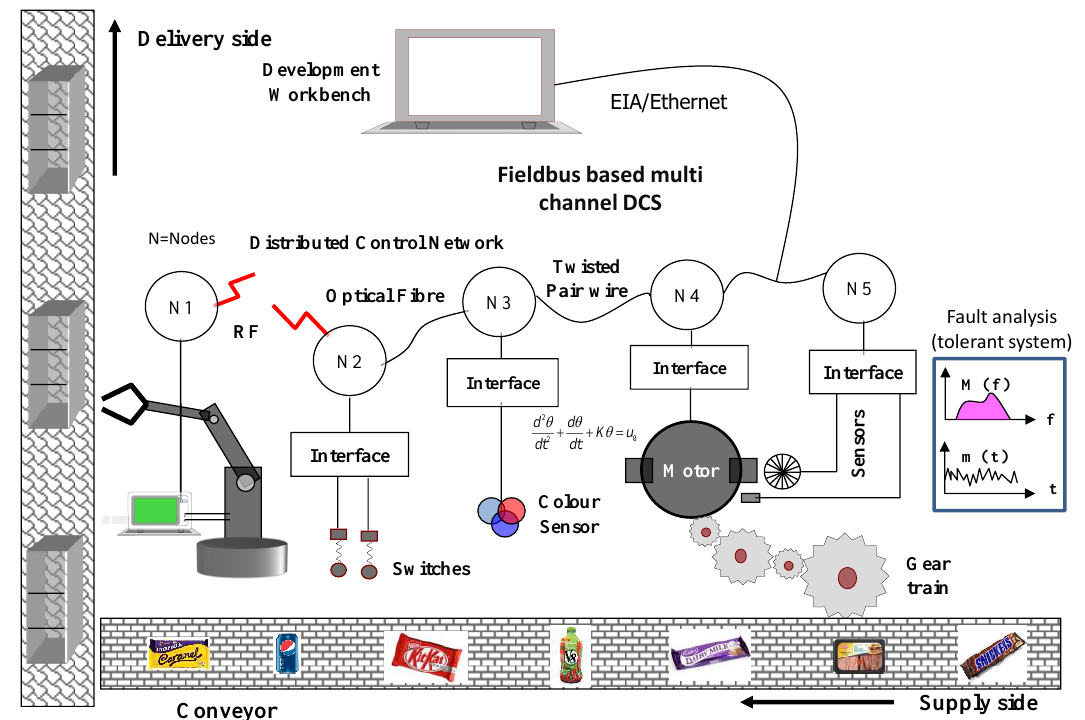
Figure 2. Distributed Control Architecture